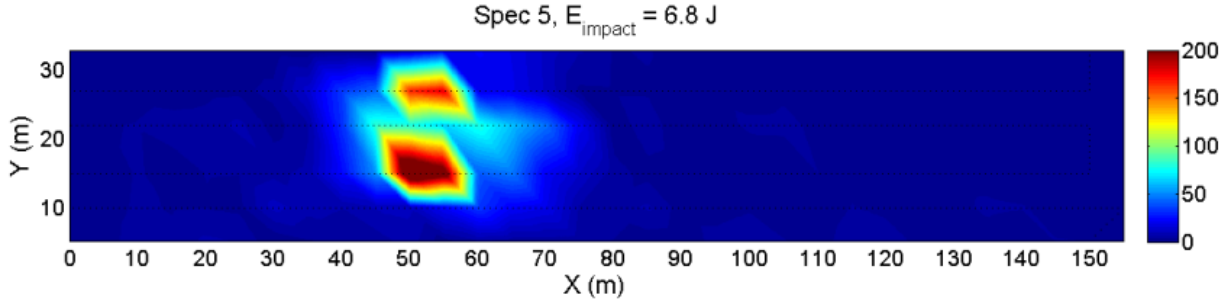
Figure 6. Delamination region to visualise failure on the ply when the Ultrasonic C-Scan inspection plot is zoomed (Reprinted/adapted with permission from Ref. [60]. Copyright year: 2016, copyright owner’s name: UPM, NDT & Patricia F. Díaz-Maroto).